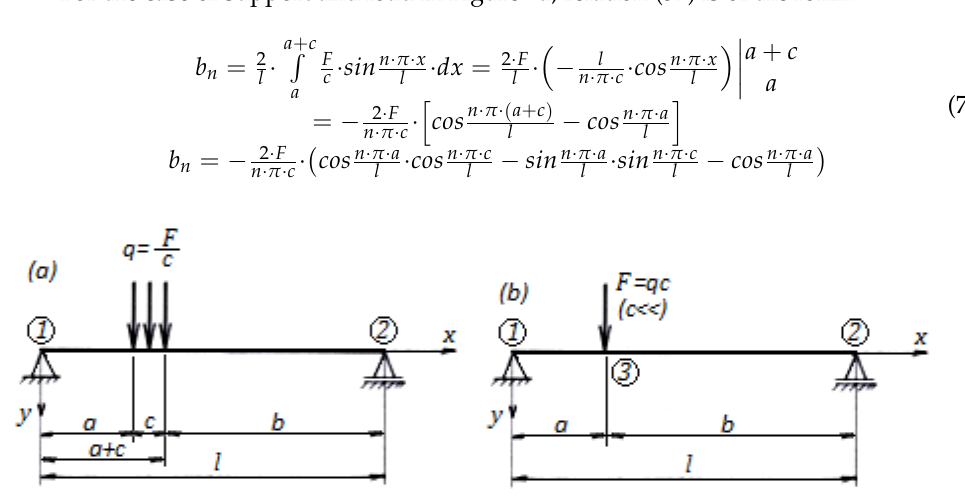
Figure 7. Simply supported bar and subjected to bending.